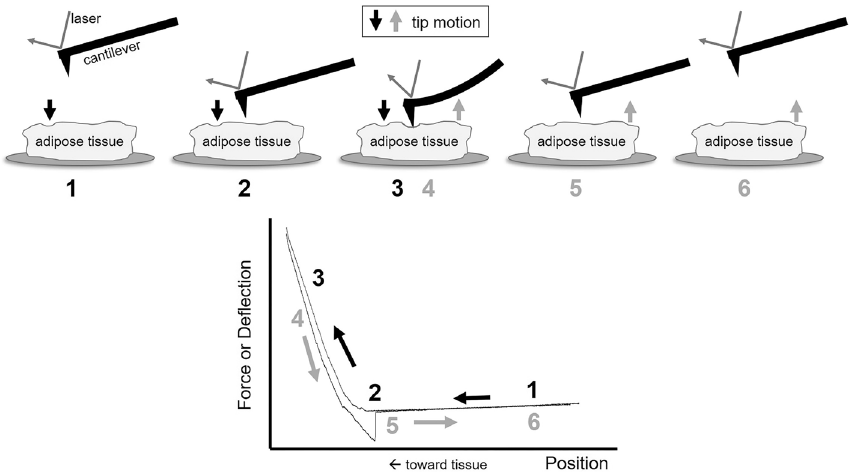
Figure 1. Schematic of AFM nanoindentation measurement with example raw force-indentation data. At point 1, the cantilever is removed from interaction with the tissue surface. The cantilever approaches the tissue surface (point 2), ultimately contacting and indenting into the tissue (points 3 and 4). Once the set point cantilever deflection has been reached (corresponding with a set force), the tip is retracted from the tissue surface (points 5 and 6). On the retraction curve, it is not uncommon to see a small spike in deflection as the tip pulls away from the sample (between points 4 and